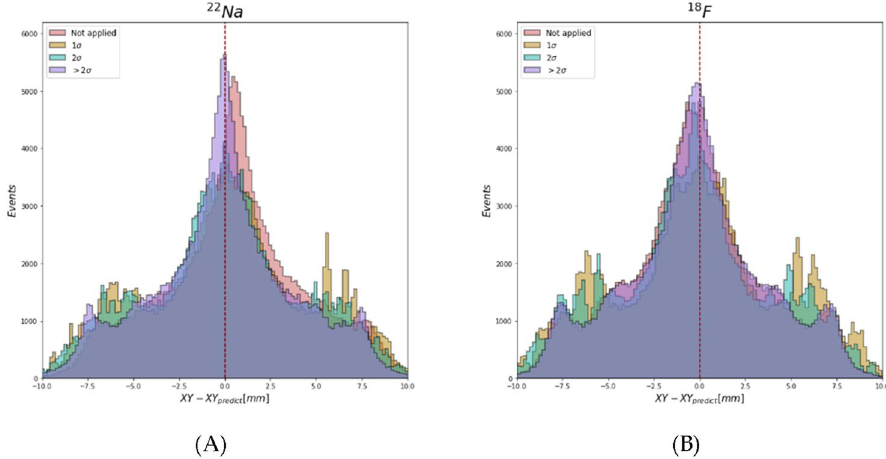
Figure 2. Difference between reconstructed and initial Ps annihilation positions corresponding to the energy cutoff range of ( A ) 22 Na and ( B ) 18 F.